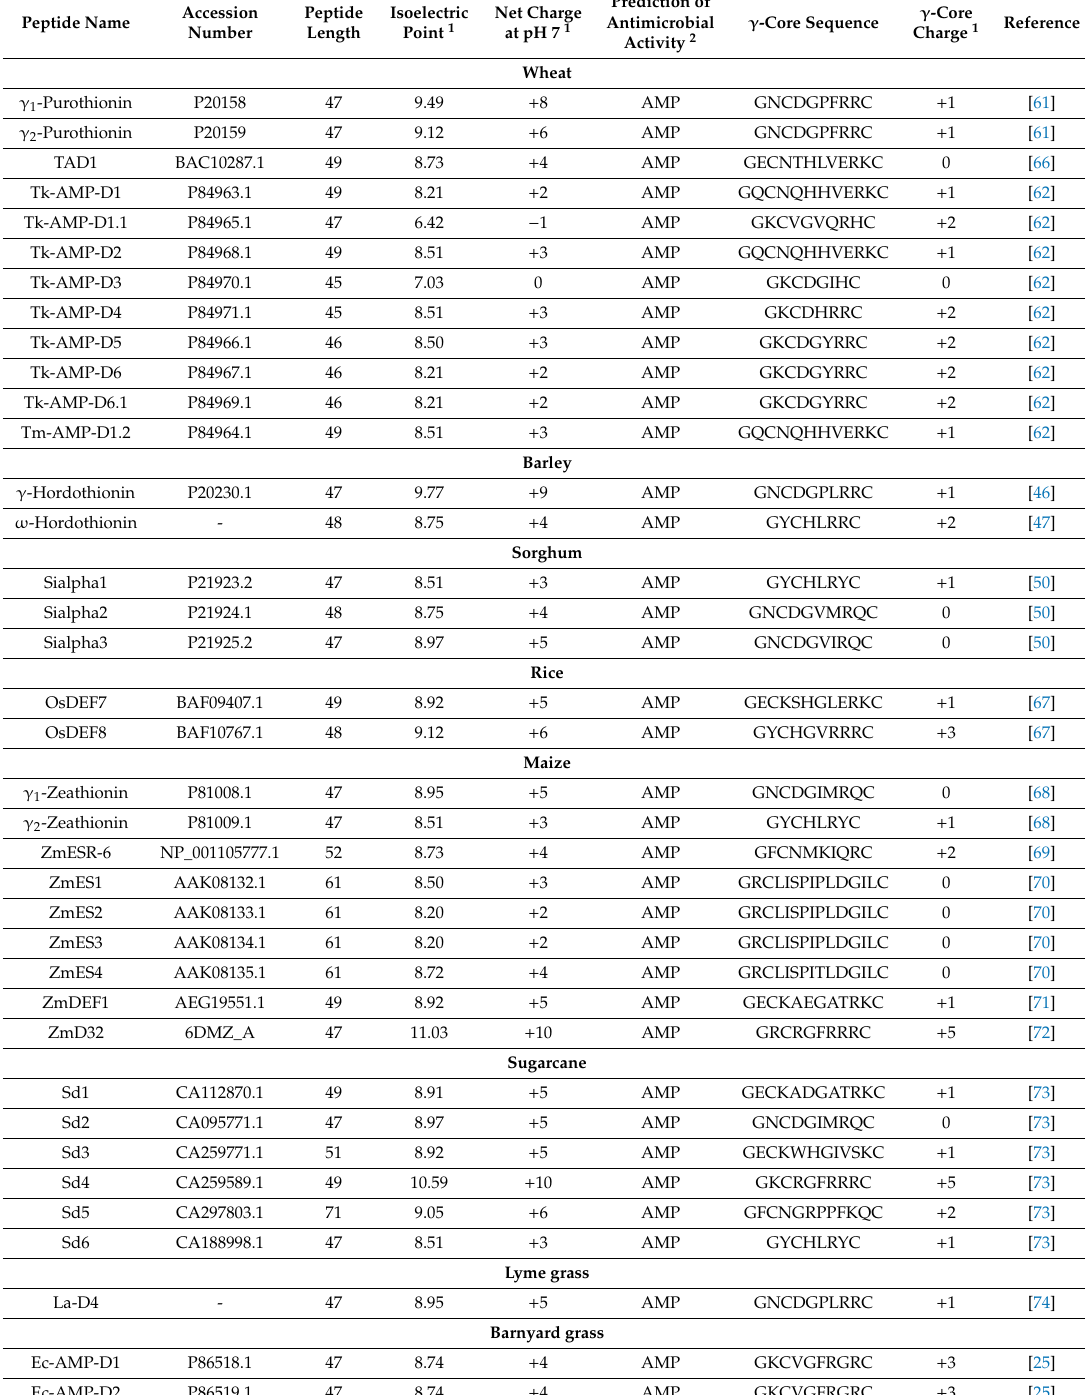
Table 1. The main characteristics of isolated grass